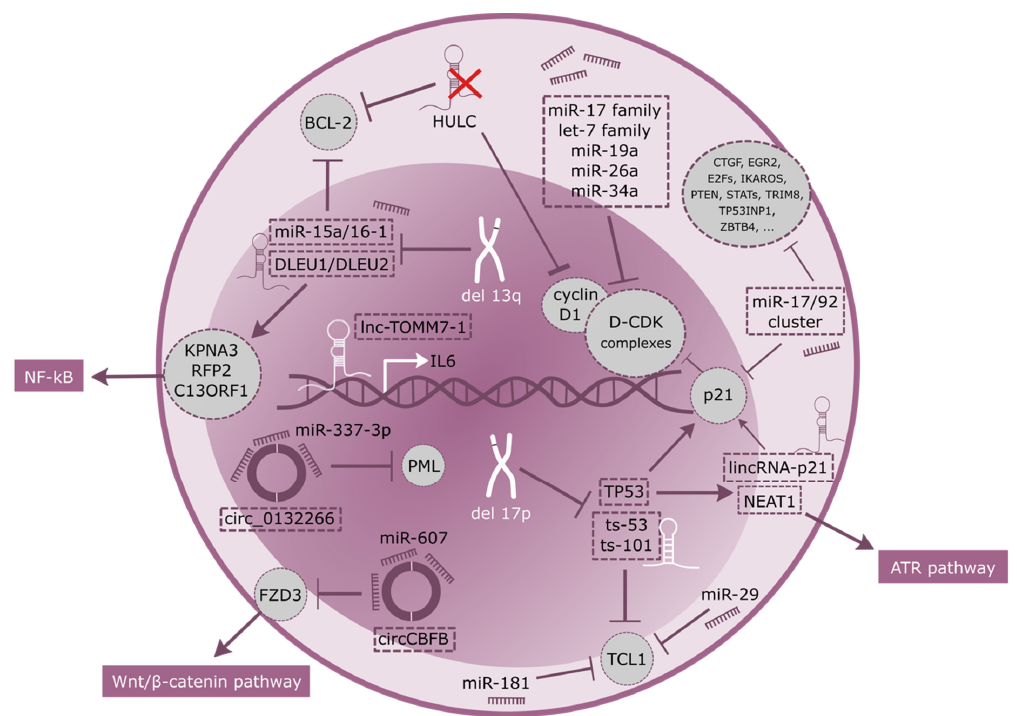
Figure 2. Sustaining proliferative signaling and resisting cell death hallmarks in CLL .